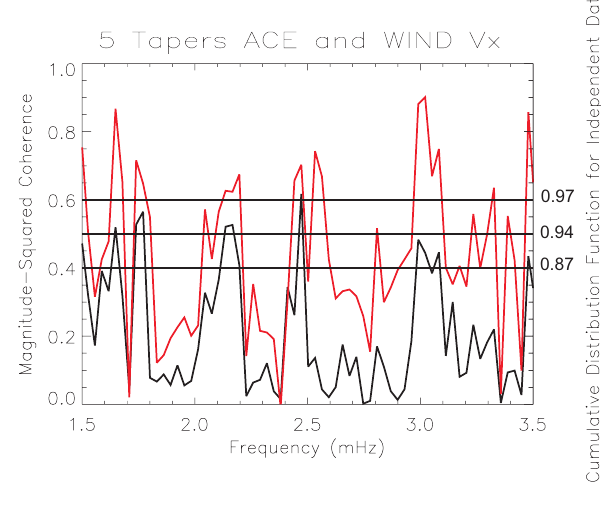
Fig. 11. MSC between ACE and WIND Vx components. Axes and curves same as Fig.